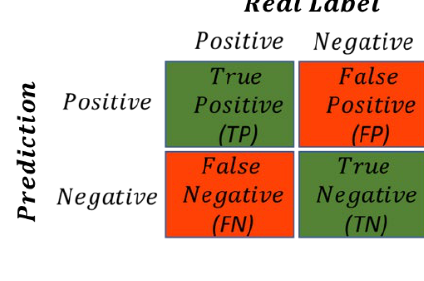
Figure 7. Confusion matrix.